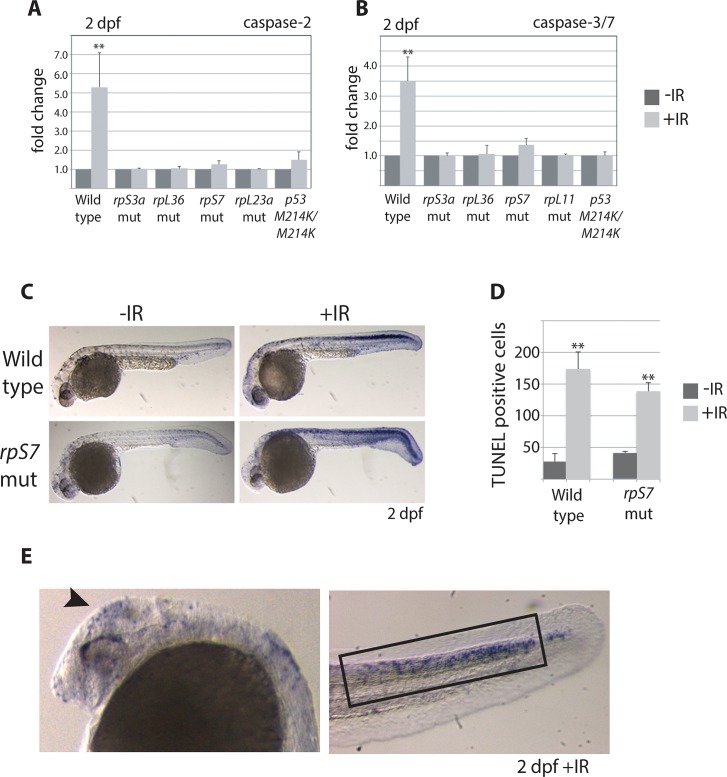
Caspase 3/7 activation is increasingly impaired in RP mutants.
A) Caspase 2 and B) 3/7 activity is measured using a proluminescent caspase-3/7 DEVD-aminoluciferin substrate in 2 dpf embryos either untreated or exposed to 25 Gy ionizing radiation (IR). C) TUNEL analysis of 2 dpf wild type or rpS7 embryos reveals cells with DNA fragmentation when embryos are exposed to 25 Gy IR. D) The number of TUNEL-positive cells in (C) are quantified. E) TUNEL-positive cells in both wild type and rpS7 mutants are observed predominantly in the brain region (arrowhead) or in the tail tissue dorsal to the notochord (black box). *p<0.05, **p<0.01.